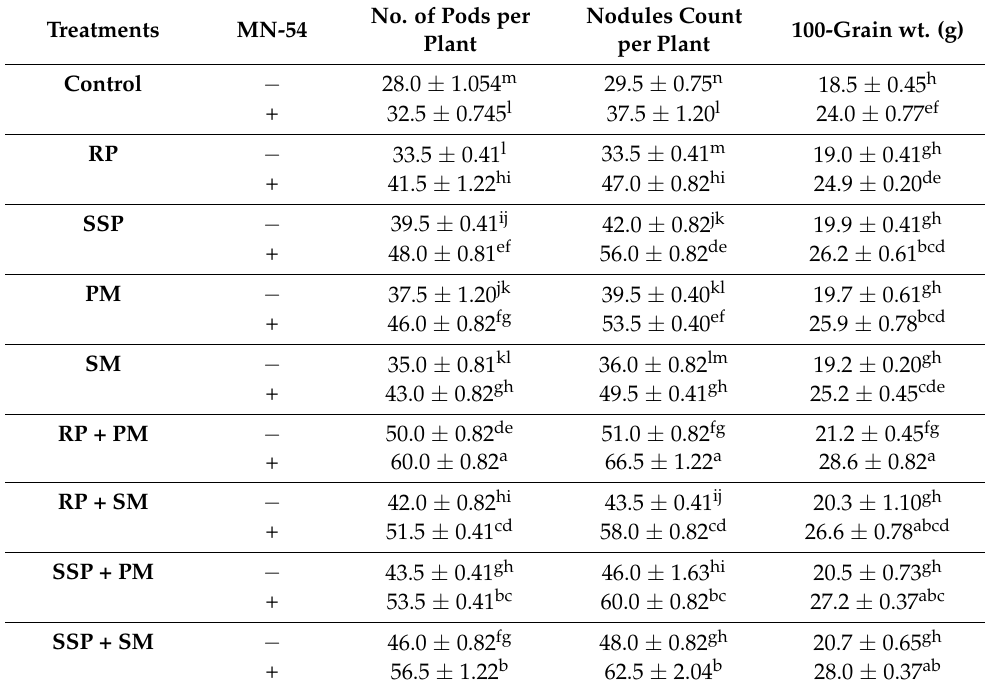
Table 3. Effect of phosphorus fertilizers, organic manures, and Bacillus sp. MN-54 addition on yield attributes of chickpea.